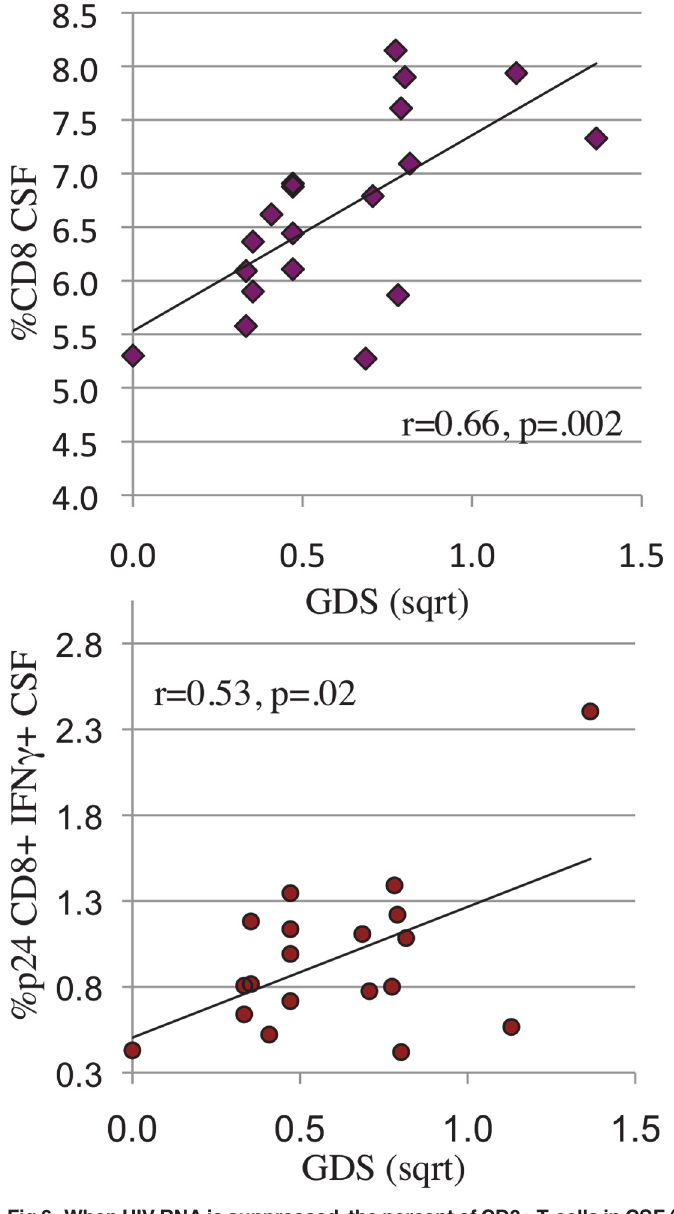
GDS were square root